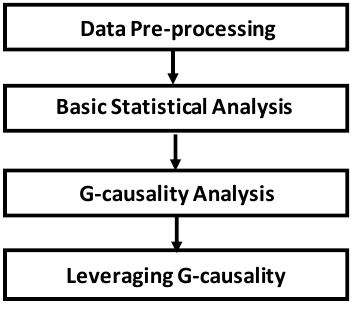
Figure 1. The CGC